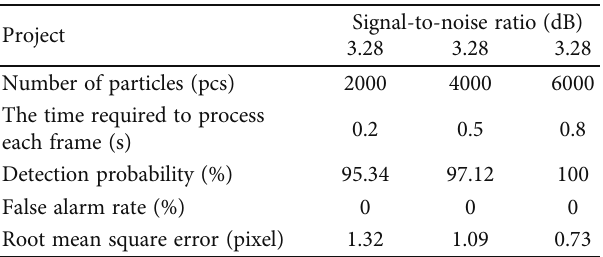
Table 2: Comparison of detection performance. Project